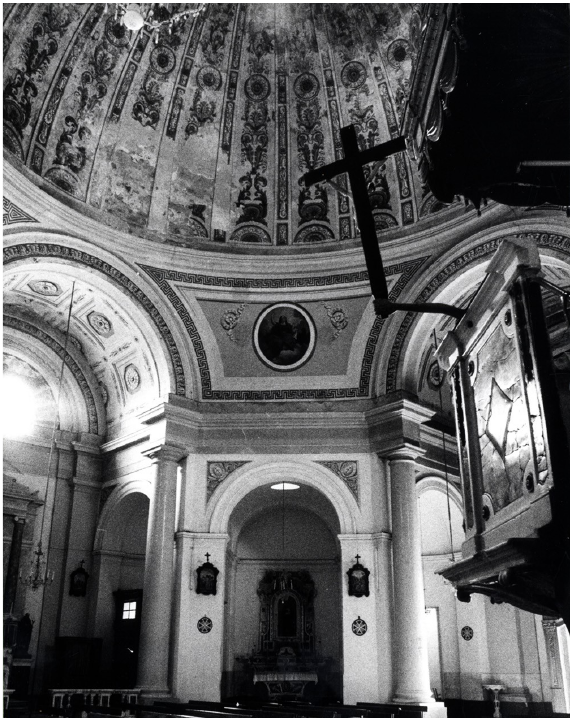
Figure 3. The internal view before the restoration in 1978 (Superintendence of BAPSAE - Provinces of Cagliari and Oristano).